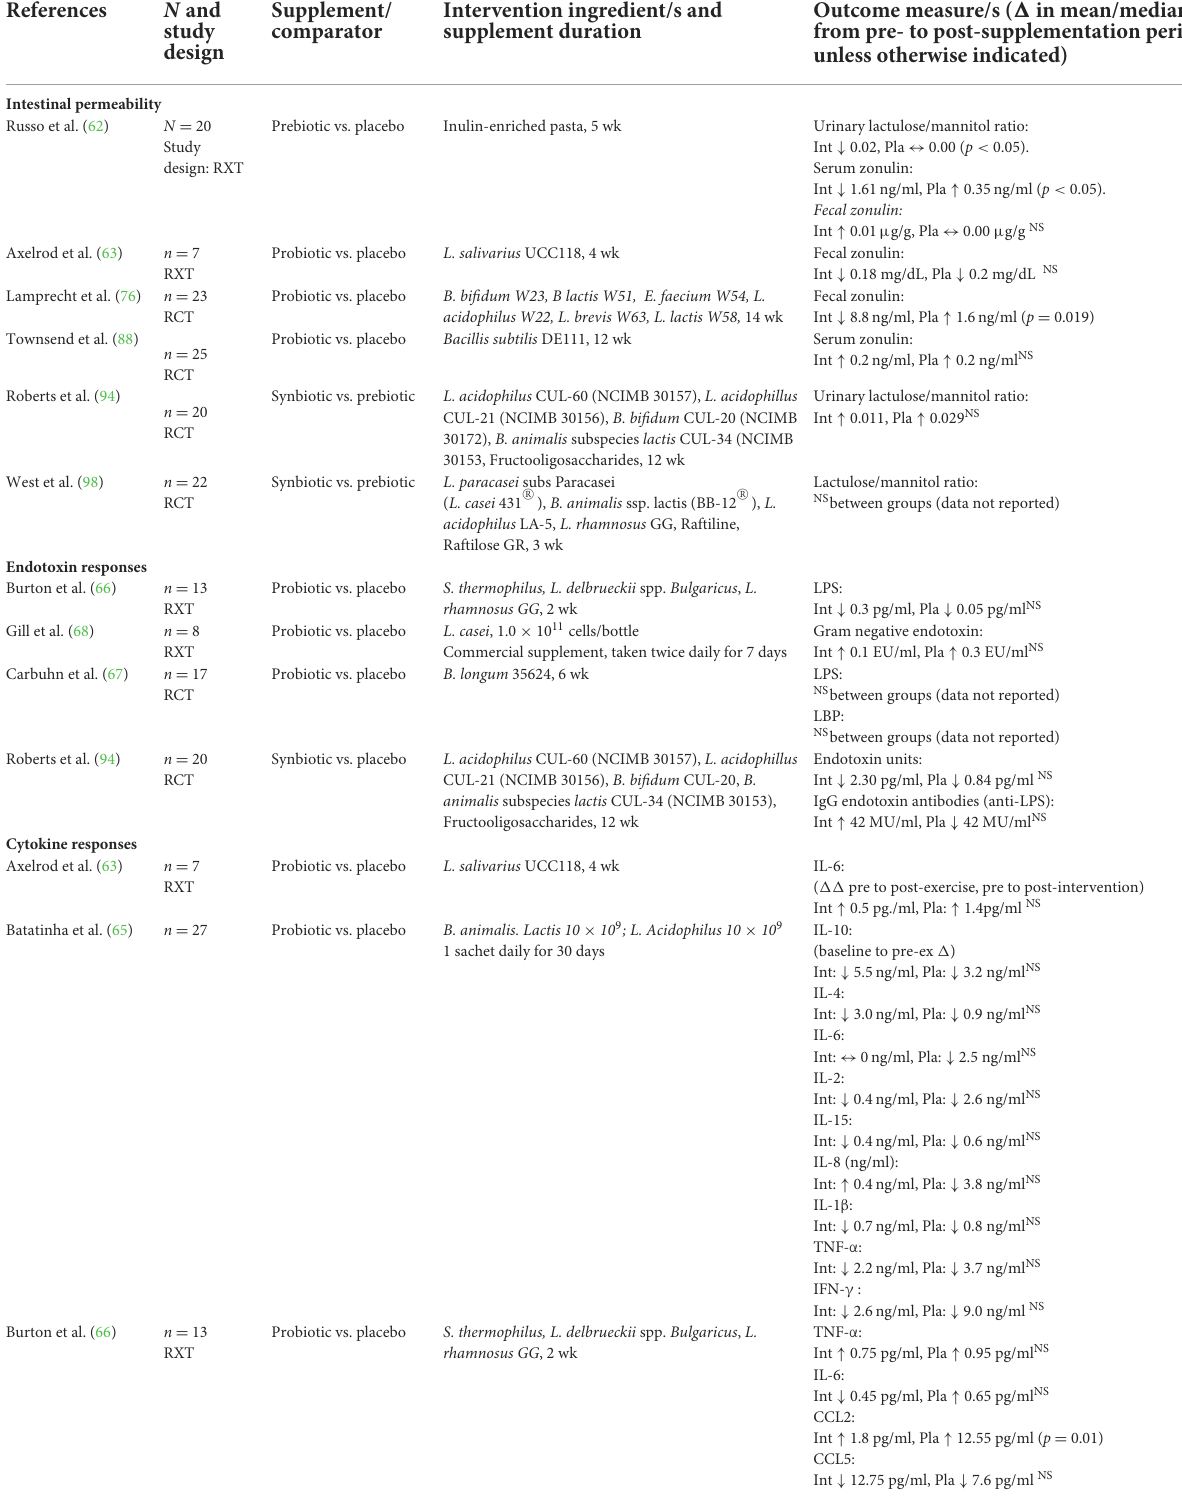
TABLE 4 Systematic review study outcomes of included studies that attempted to determine the impact of prebiotic, probiotic, and synbiotic supplementation on gastrointestinal outcomes at